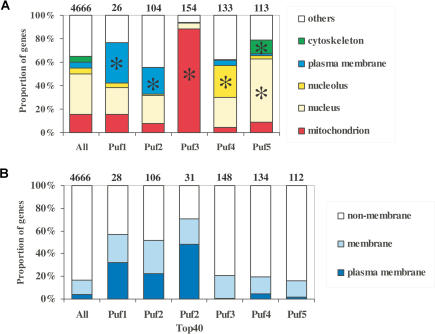
Classification of mRNAs Interacting with Puf Proteins(A) Column charts showing compartmentalization of characterized gene products encoded by the Puf targets. The same compartments are shown for the entire genome in the columns designed “All” (YPD, May 2003). The number of genes represented in the charts is indicated on the top of columns. An asterisk indicates classes with p values of less than 0.001.(B) Fraction of membrane-associated gene products among the Puf targets. We classified the targets by combining both GO and YPD annotations (May 2003). “Plasma membrane” (light blue) is a subpopulation of the total membrane-associated proteins (blue). Soluble cytoplasmic or nuclear proteins were classified as “non-membrane.” “All” refers to the genome-wide compartmentalization of characterized genes, and respective numbers were retrieved from YPD. “Puf2 Top 40” refers to the 40 highest enriched Puf2p targets and equals the total number of Puf1p targets.